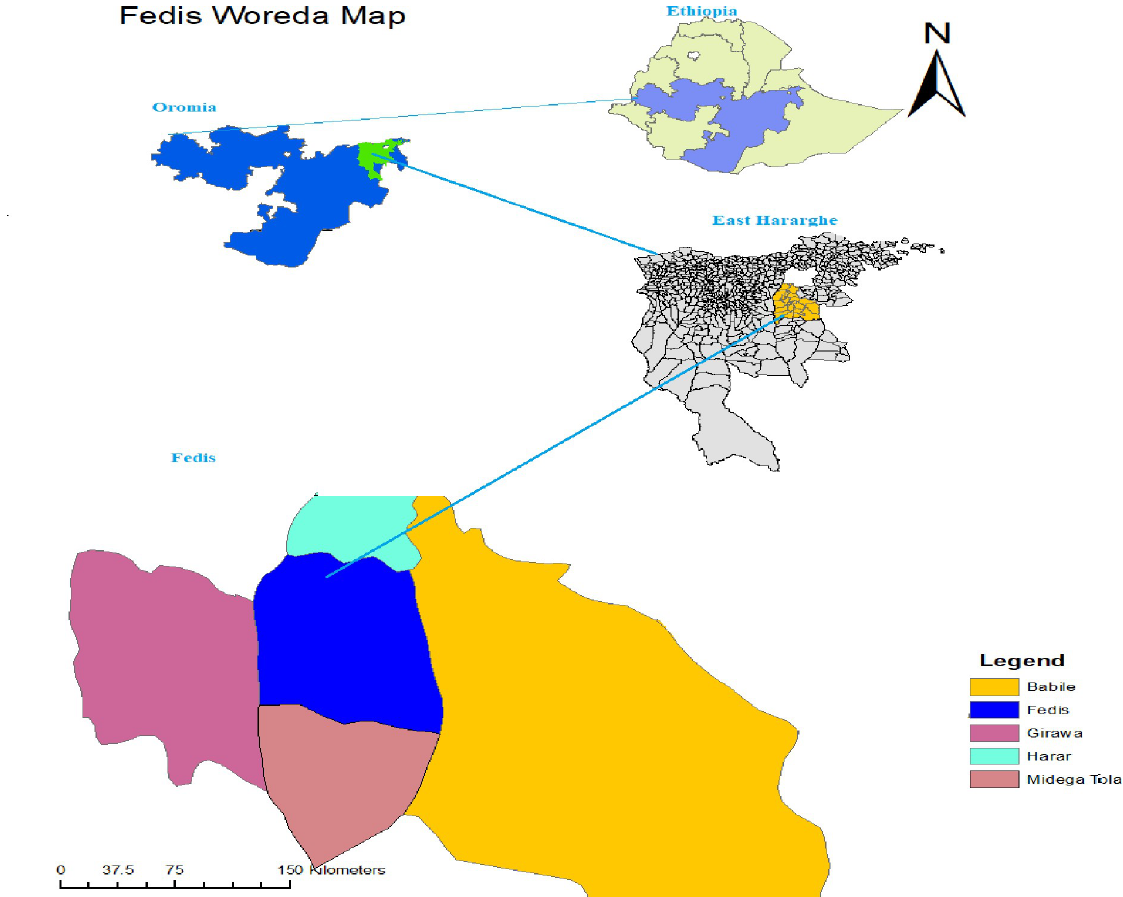
Fig 1. Map showing the location of study site in Ethiopia 2019: Fedis district, drawn using ARCGIS version 10.1. (source: "Natural Earth.